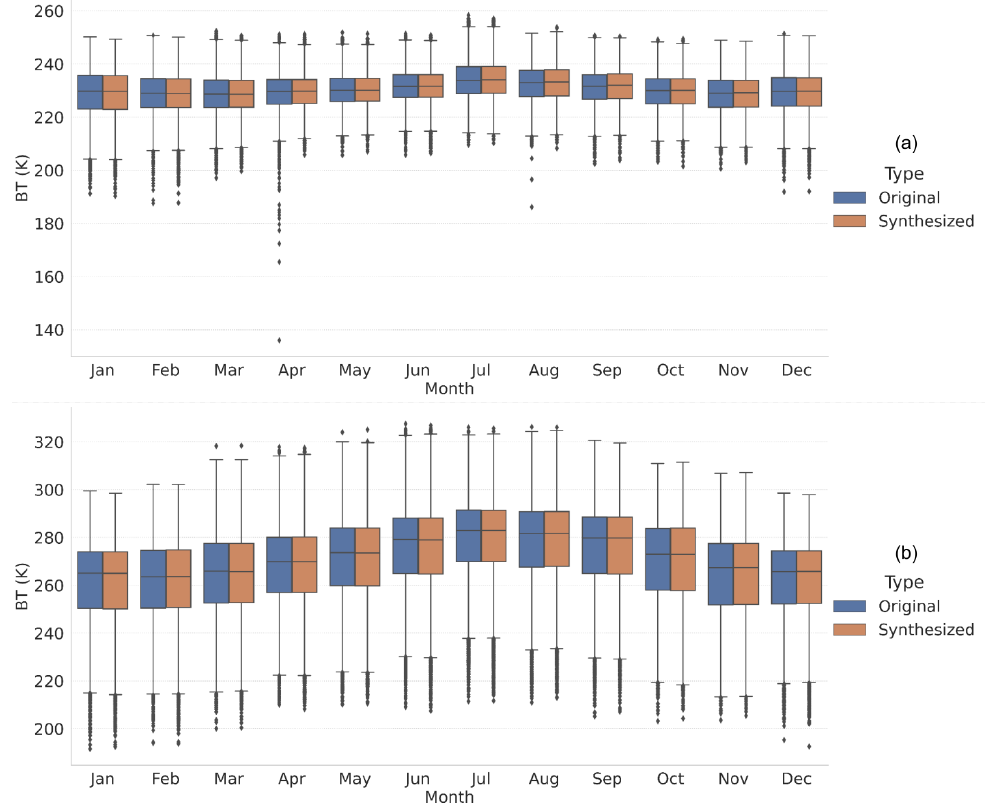
Figure 14. Monthly comparison of original and synthesized MFG scenes for ( a ) WV, and ( b ) IR channel. Box plots of the distribution of original vs. predicted BT values (K) for each month of the year. The boxes represent the 25th, 50th, and 75th percentiles. Whiskers extend 1.5 times the IQR to the most extreme data point (75–25th